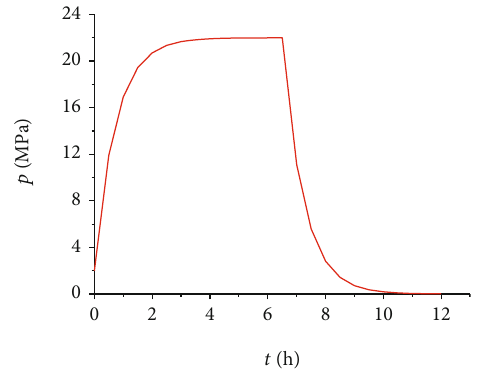
Figure 2: Variation of the frost heaving pressure with time during one freeze-thaw